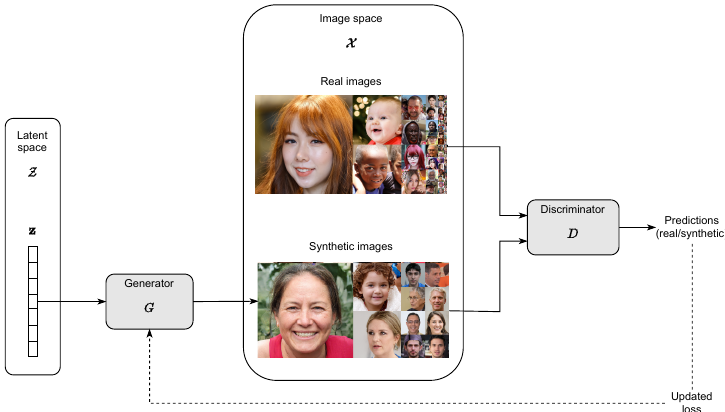
Figure 2. GAN architecture and training scheme.